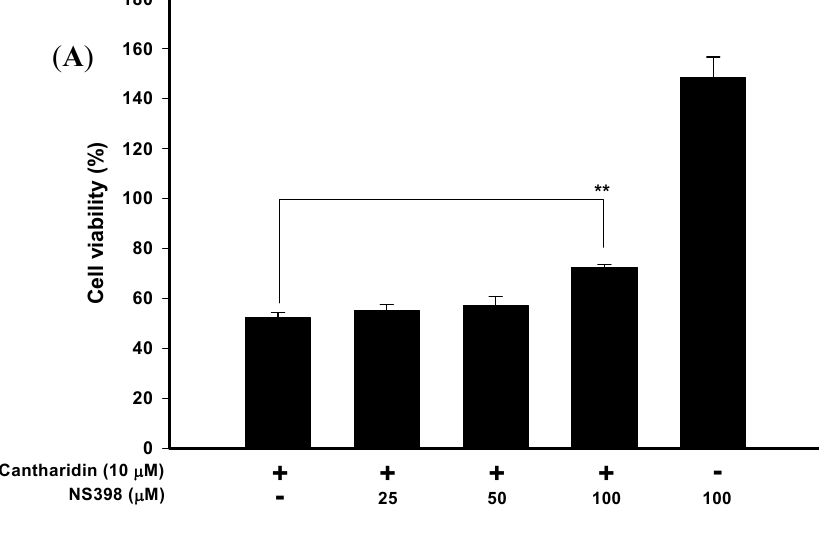
Figure 2. NS398 significantly inhibited cantharidin-induced ( A ) cytotoxicity and ( B ) PGE production in T24 cells. NS398: A selective COX-2 inhibitor. ** p < 0.001. n =